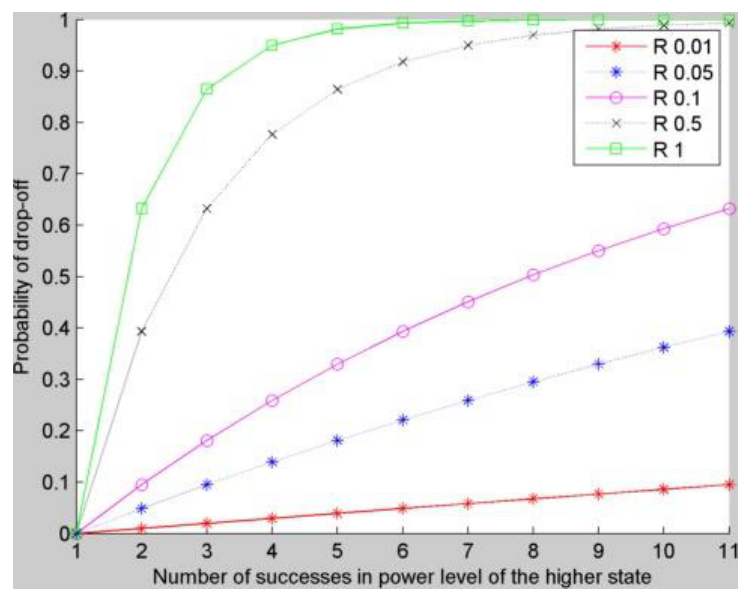
Figure 2. The curves behave differently depending on the value of R. A low R value indicates slow back off while a high R indicates fast back off. When the number of successes is 0, the probability of transition is 0. This drop-off algorithm takes into account of all the previous successes indicating that it also uses past history while